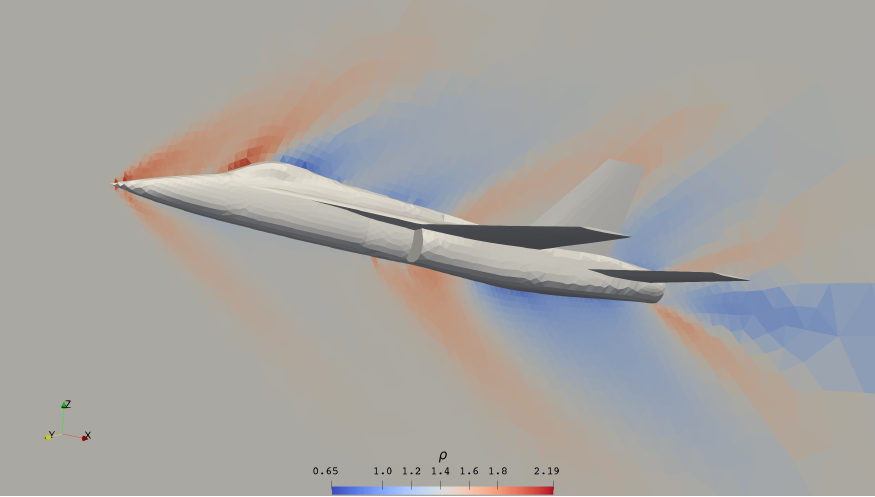
Figure 24. Density contour obtained from the first-order solution of Problem